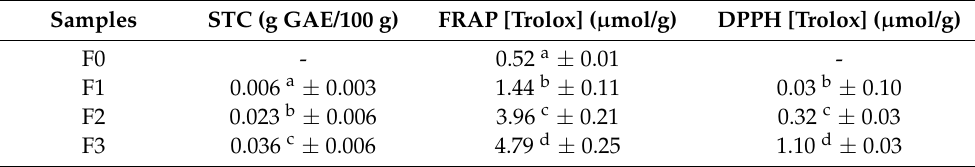
Table 5. Soluble tannin content (STC) and antioxidant activity of muffins.